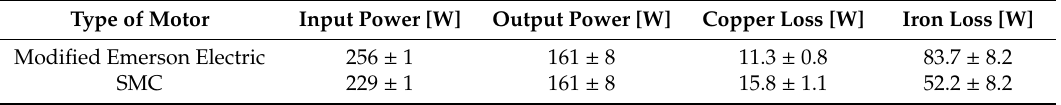
Table 4. Power loss for modified Emerson Electric and SMC motors for T = 0.35 Nm, n = 4400